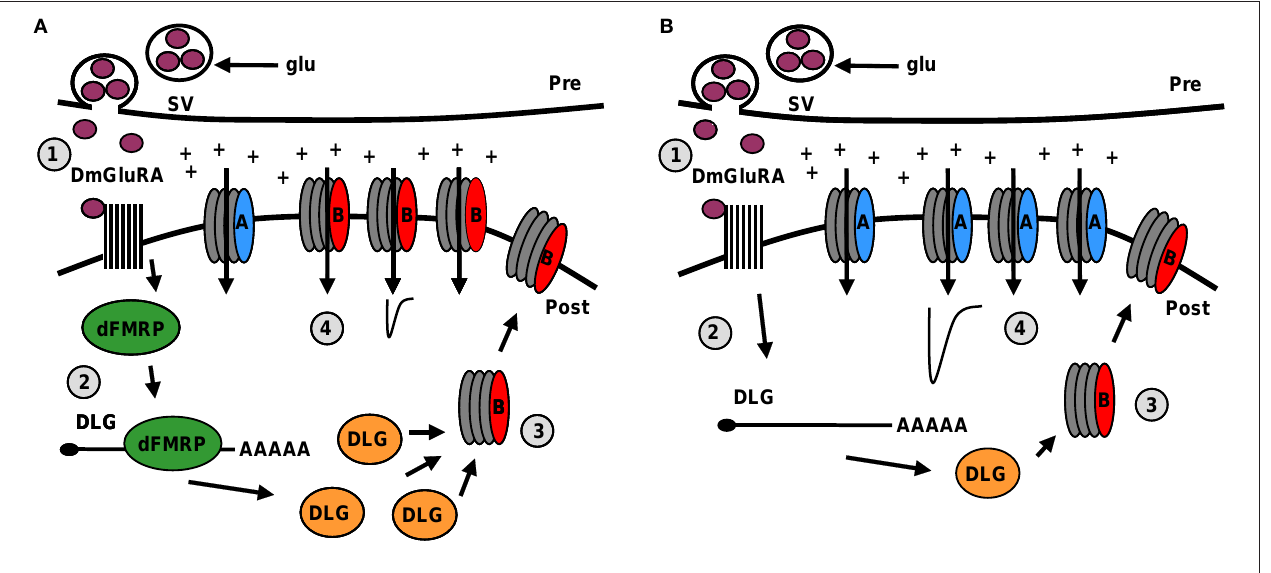
FIGURE 4 | Model of DmGluRA signaling and dFMRP function regulating postsynaptic changes. (A) In step 1, presynaptic glutamate (glu) release from synaptic vesicles (SV) stimulates the DmGluRA receptor to regulate dFMRP. In step 2, dFMRP regulates the stability of DLG/PSD-95 mRNA resulting in an increase in protein levels. In step 3, DLG facilitates the insertion of GluRIIB class